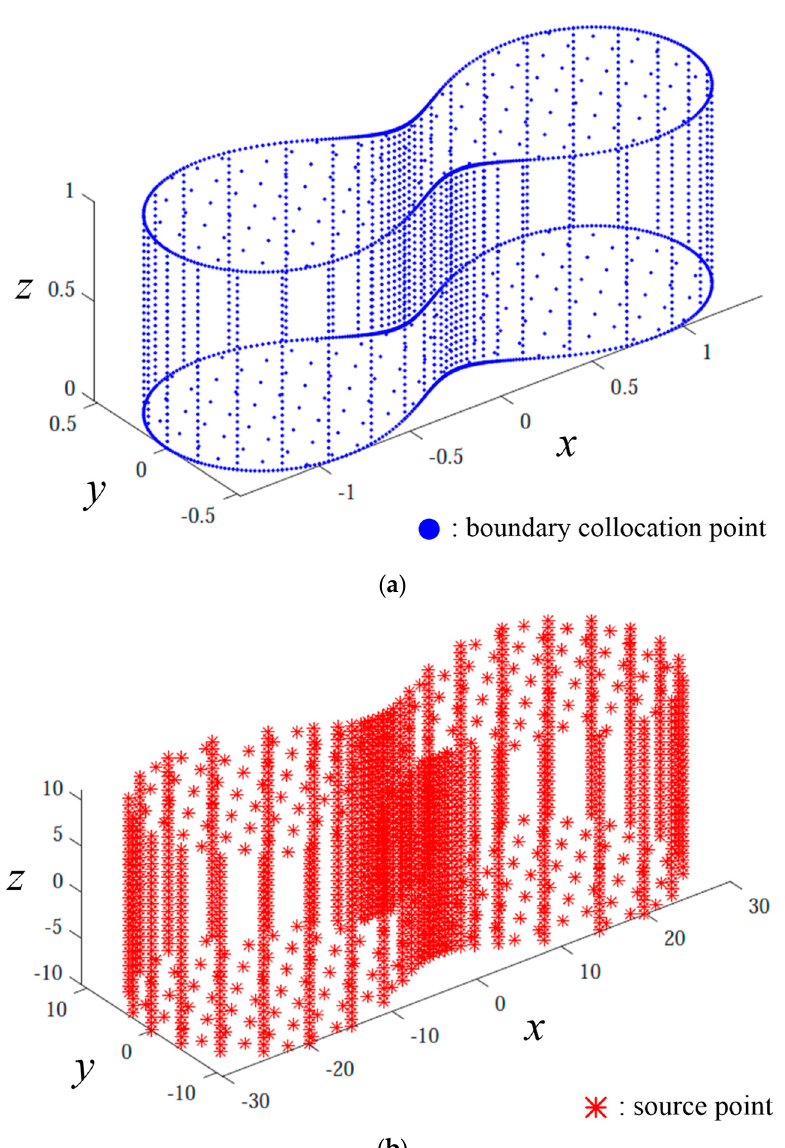
Figure 3. A three-dimensional peanut-shaped domain for the analysis. ( a ) Boundary collocation points and ( b ) source points.